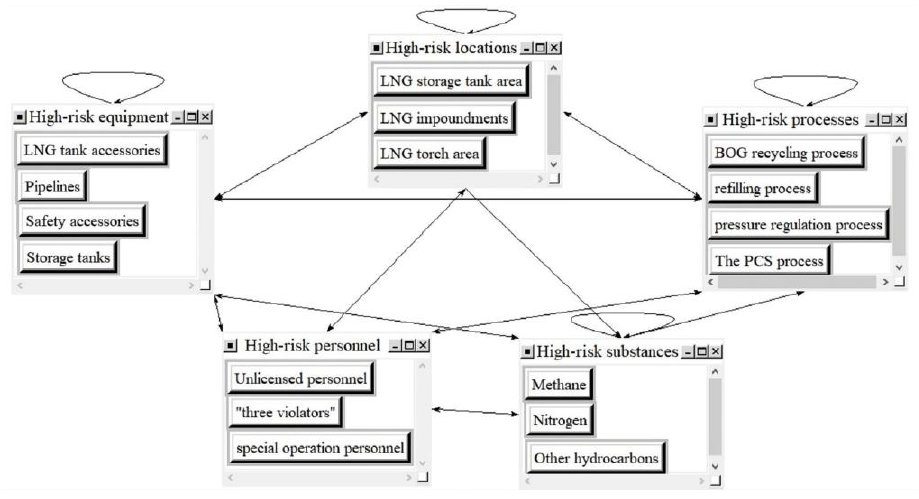
Figure 4. ANP structure model.